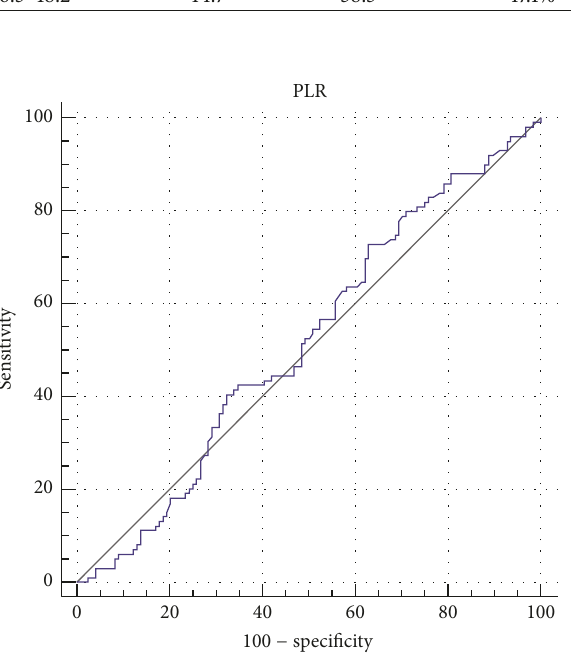
PTMC, with extrathyroidal invasion and lymph node metas- tases, requiring aggressive surgery [2,